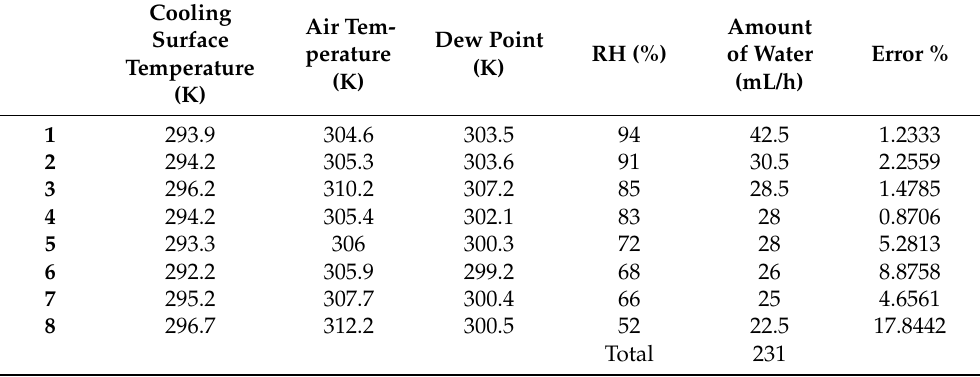
Table 5. Recorded data for experimental test (under actual weather conditions in Kuwait).